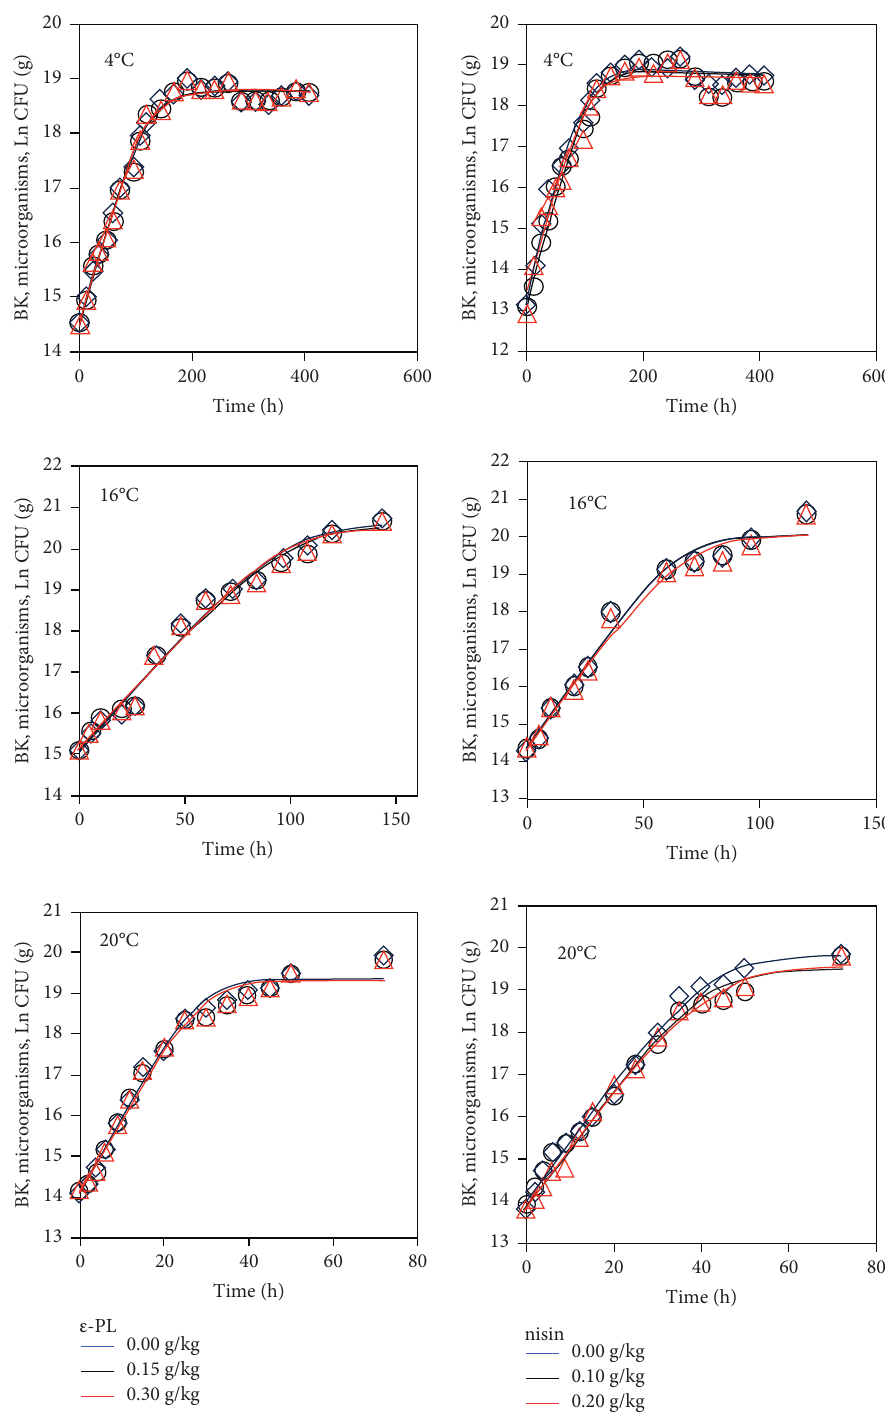
Figure 2: Growth of BK microorganisms in FVFB and curve-fitting at 4, 16, and 20 ° C: (a) ε -PL treated and (b) nisin treated. Solid line: no lag phase model; symbol: observed growth